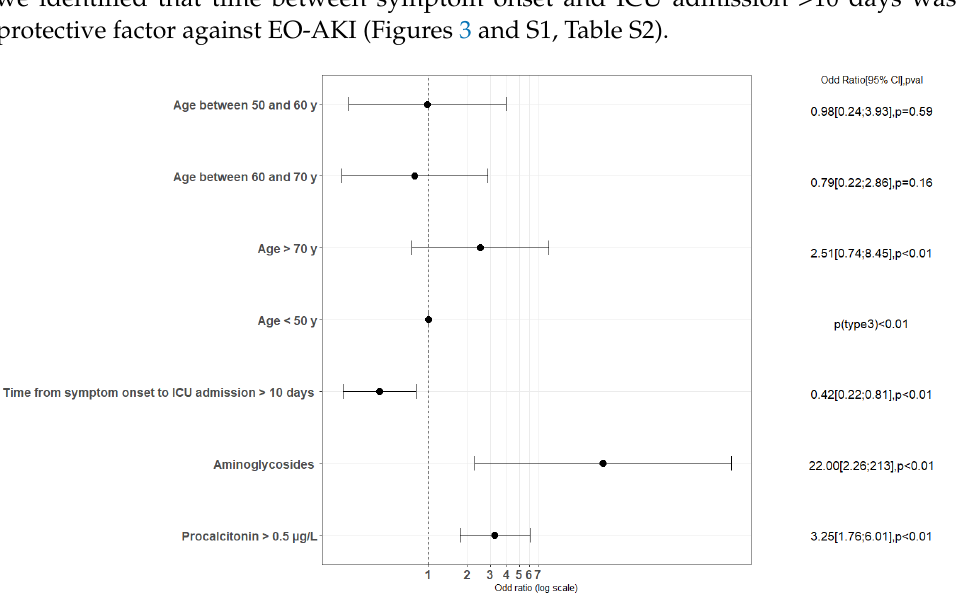
Figure 3. Factors associated with occurrence of AKI, multivariate analyses, logistic regression model. Variables with a p -value < 0.1 in the univariate analyses were age, cardiovascular disease, impaired immune system, time from first symptoms to ICU admission, antimicrobial therapy, aminoglycosides, vasopressors, invasive mechanical ventilation, bacteriemia on admission and procalcitonin. Because of correlations, only the following covariates were tested in multivariate analysis: age, cardiovascular disease, impaired immune system, time from first symptoms to ICU admission, aminoglycosides, vasopressors and procalcitonin.